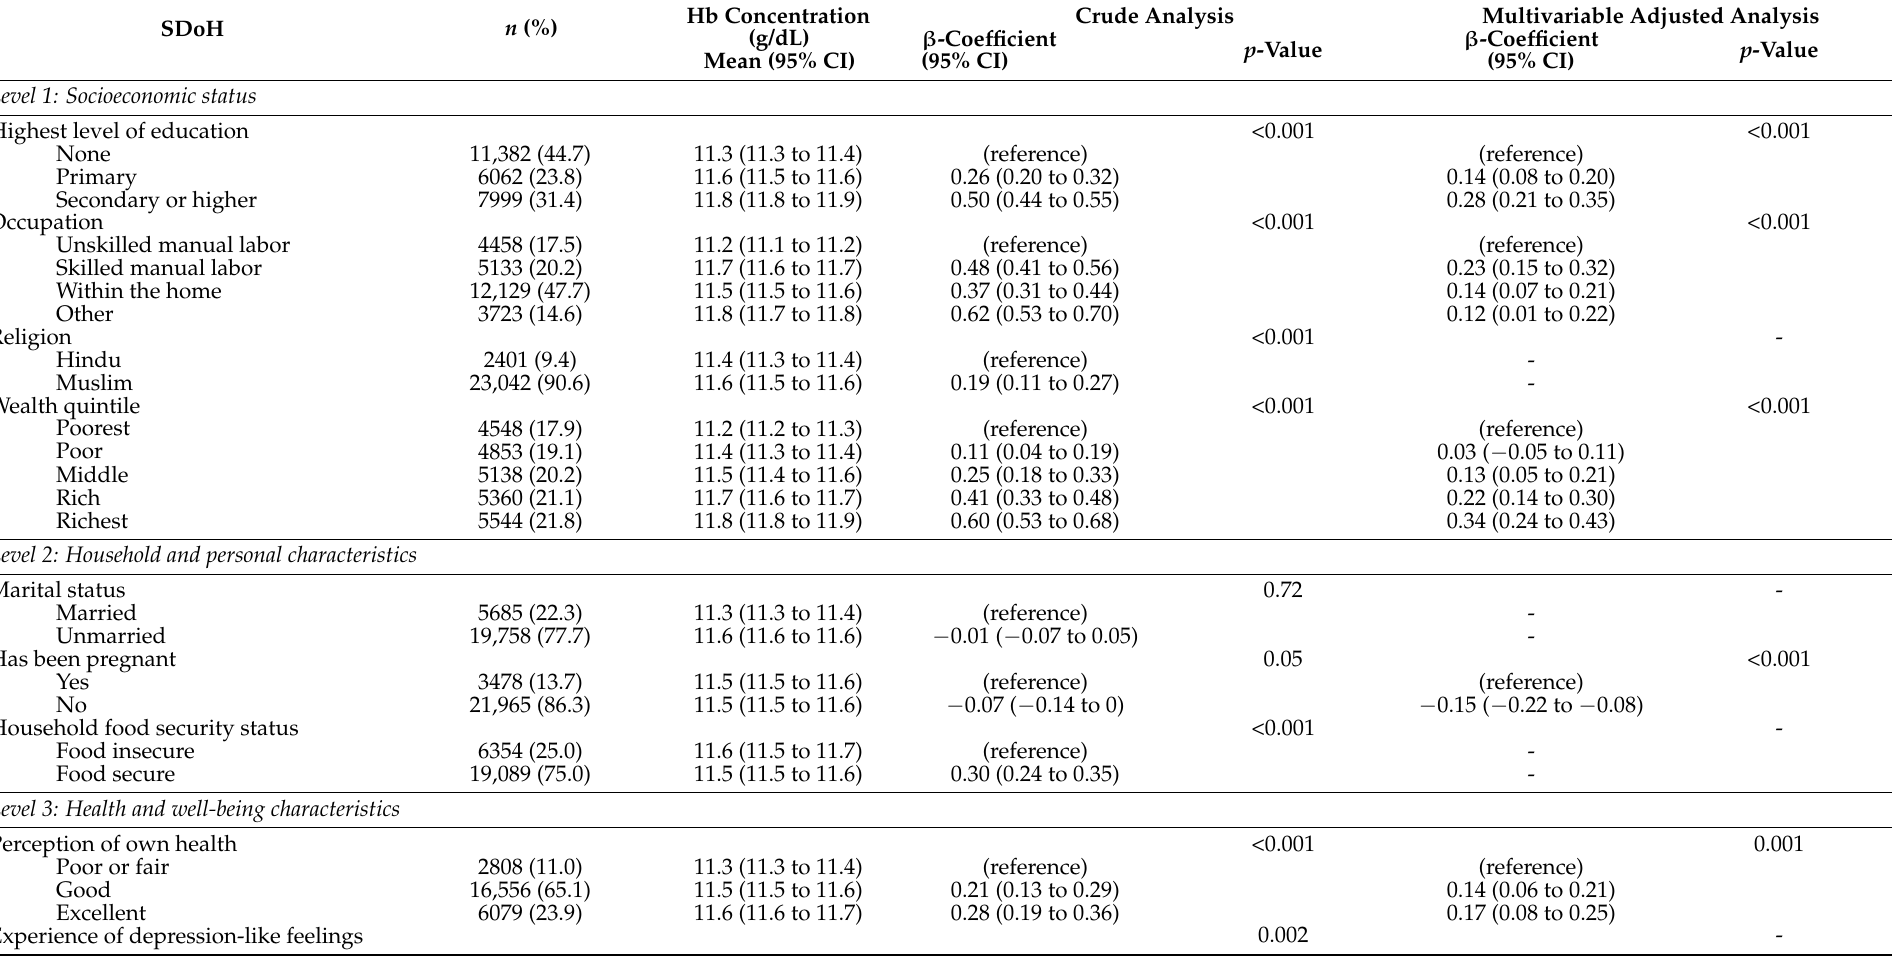
Table 3. Comparison of SDoH with Hb concentration among participants in the MaPPS Trial at enrolment ( n =